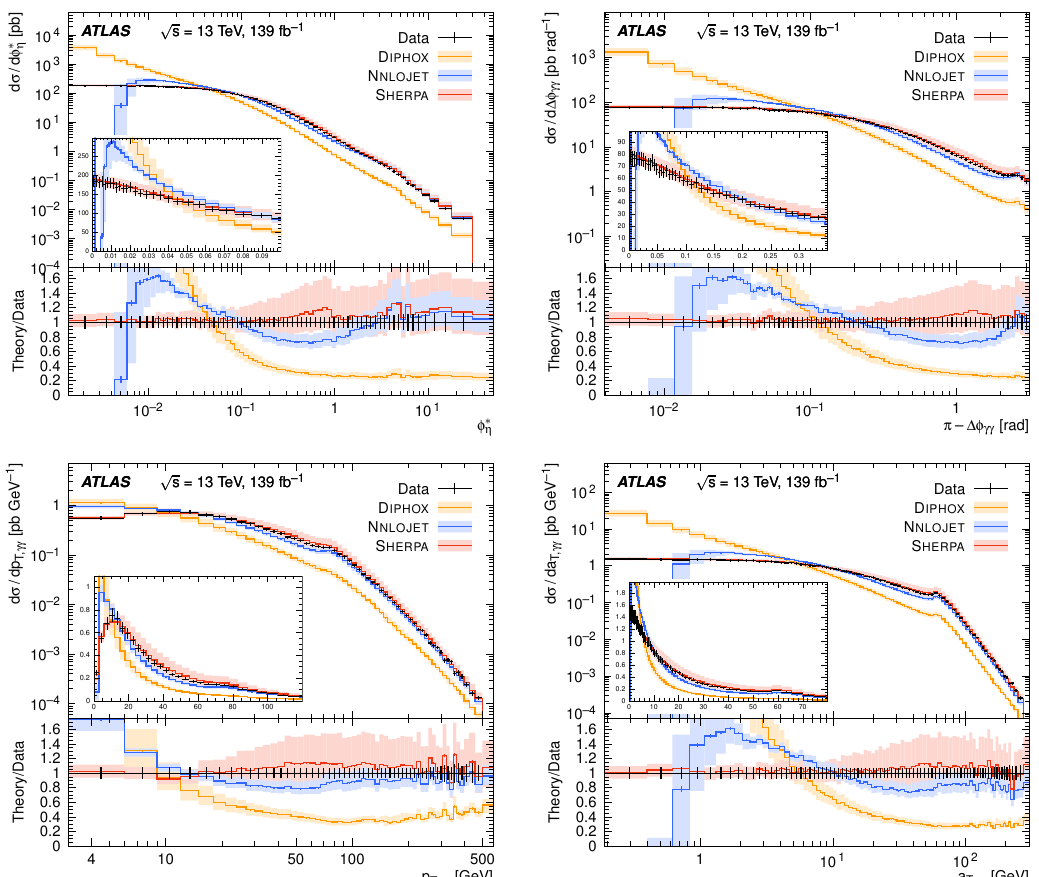
, π − ∆ φ , p , and a γγ T ,γγ T ,γγ η , p and a the last bin is only T ,γγ T ,γγ η